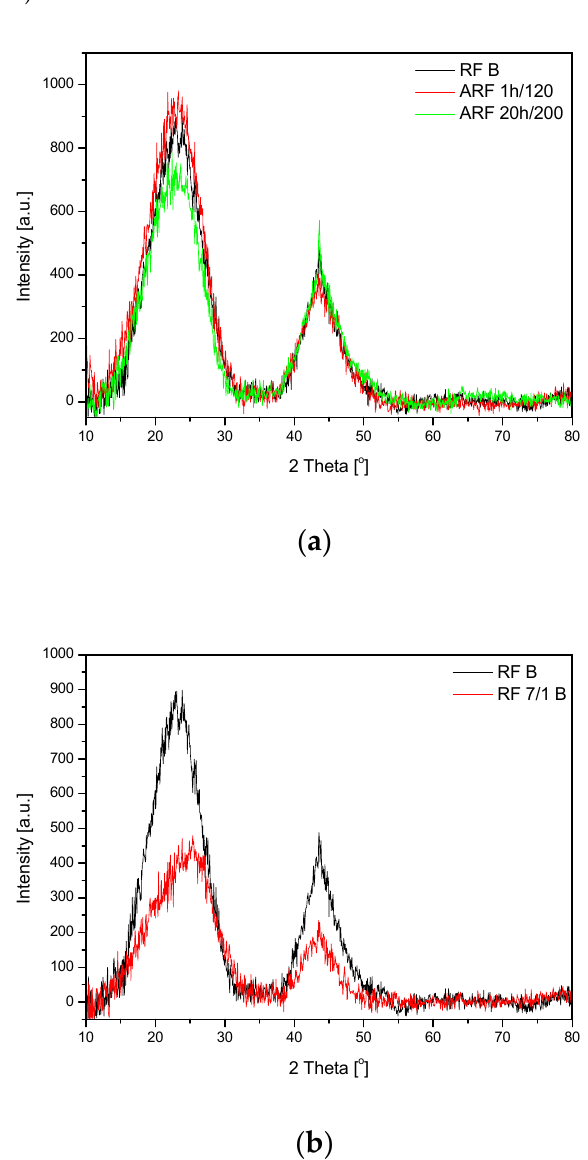
Figure 2. X-ray di ff raction patterns of the samples without addition of potassium oxalate and treated under di ff erent experimental conditions ( a ) and the samples not treated in the autoclave ( b ). For the samples with addition of potassium oxalate (the di ff raction patterns not shown here), similar results as described above were also